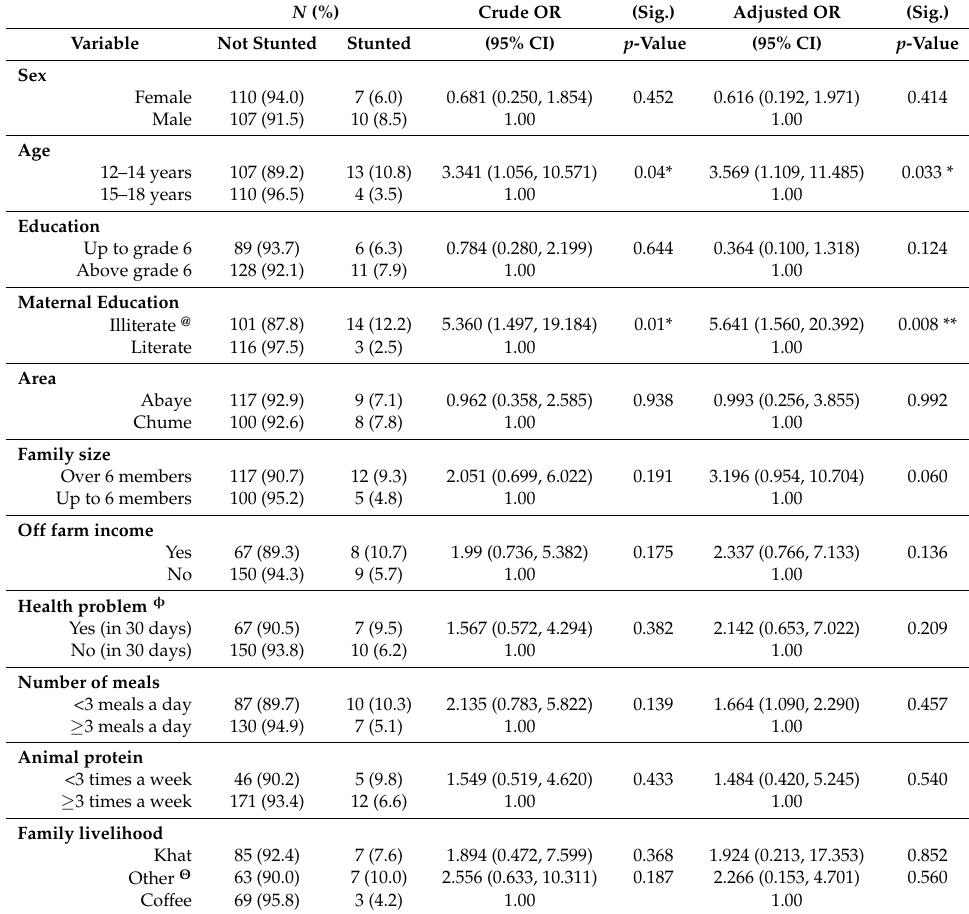
Table 2. MultivariateanalysesofriskfactorsforstuntingofadolescentsintheSidamaZone, SouthernEthiopia. N (%) Crude OR (Sig.) Adjusted OR (Sig.) Not